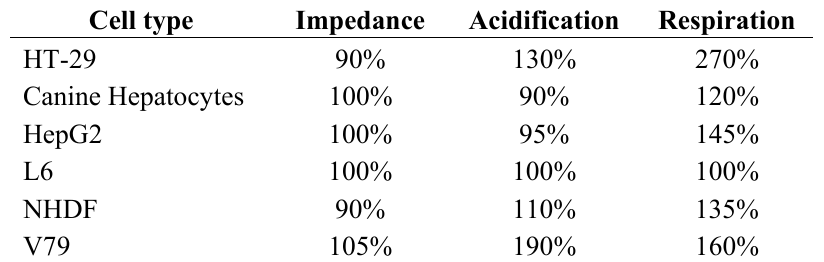
Table 2. Relative changes (in percent of normalized value after 3 h) of the cellular parameters of six evaluated cell lines after 18 h monitoring in the Bionas